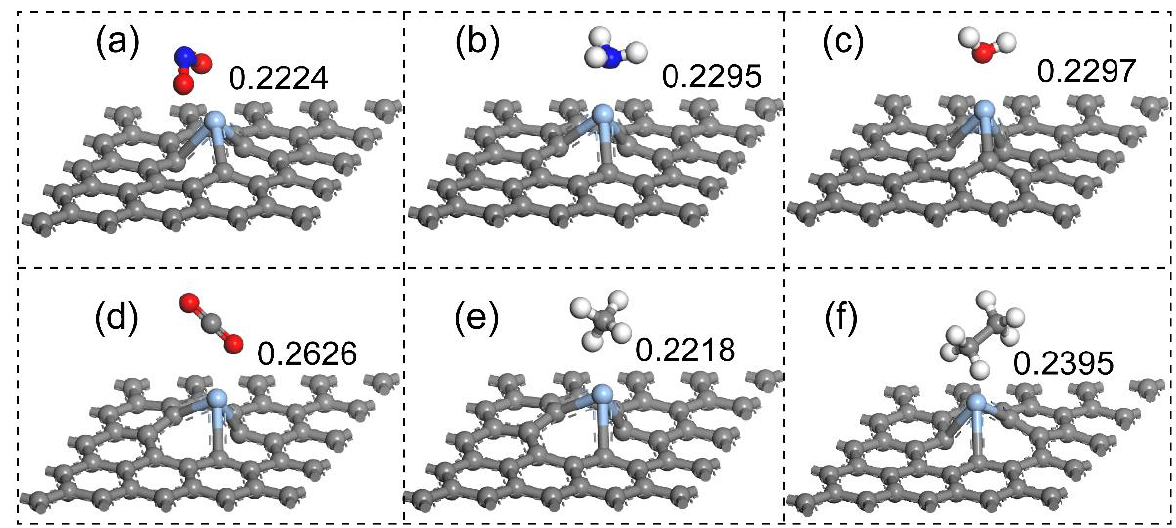
Figure 1. The optimal stable adsorption configurations of Ag–Gr with ( a ) NO 2 , ( b ) NH 3 , ( c ) H 2 O, ( d ) CO 2 , ( e ) CH 4 , and ( f ) C 2 H 6 .